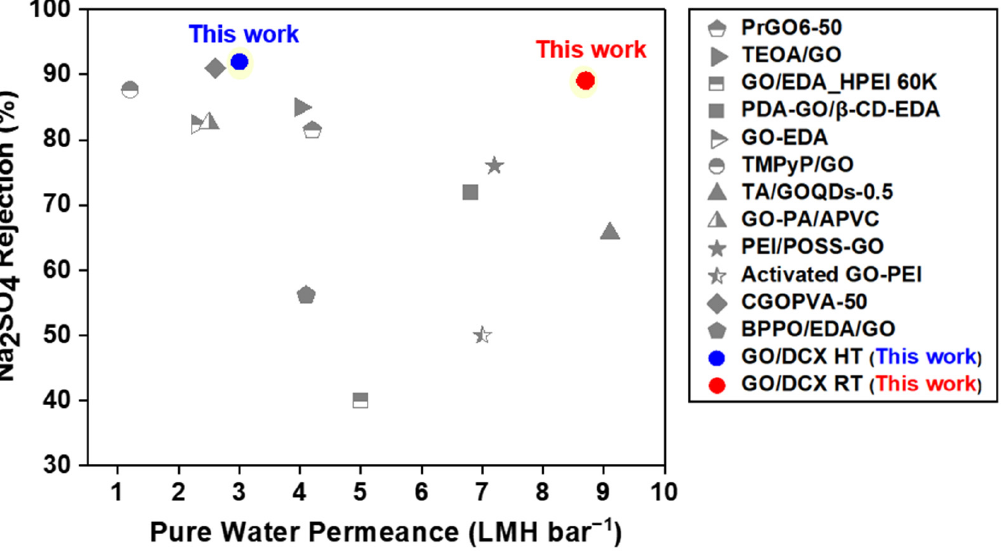
Figure 10. Performance comparison plot showing the Na2SO4 rejection efficiencies and the PWP of GO-based NF membranes, including our GO membranes [54–65].